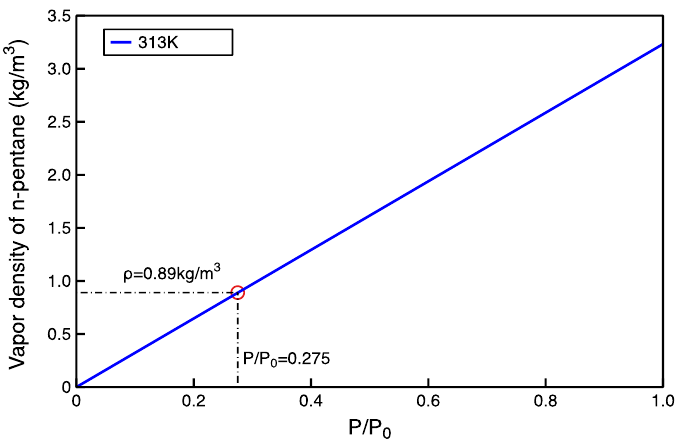
Figure 5. Density map of n-pentane at different relative pressures (according to NIST [44]).